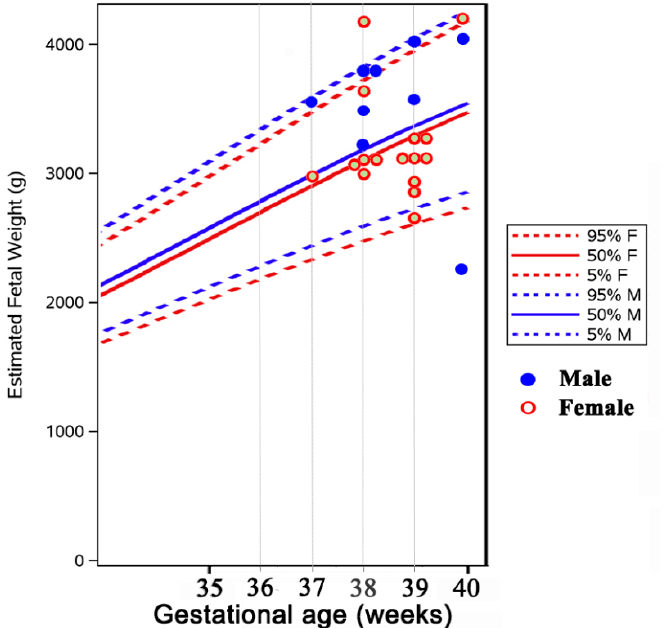
Figure 1. Distribution of birth weight in newborns from mothers with hyperthyroidism (plotted on the WHO fetal growth chart [18].